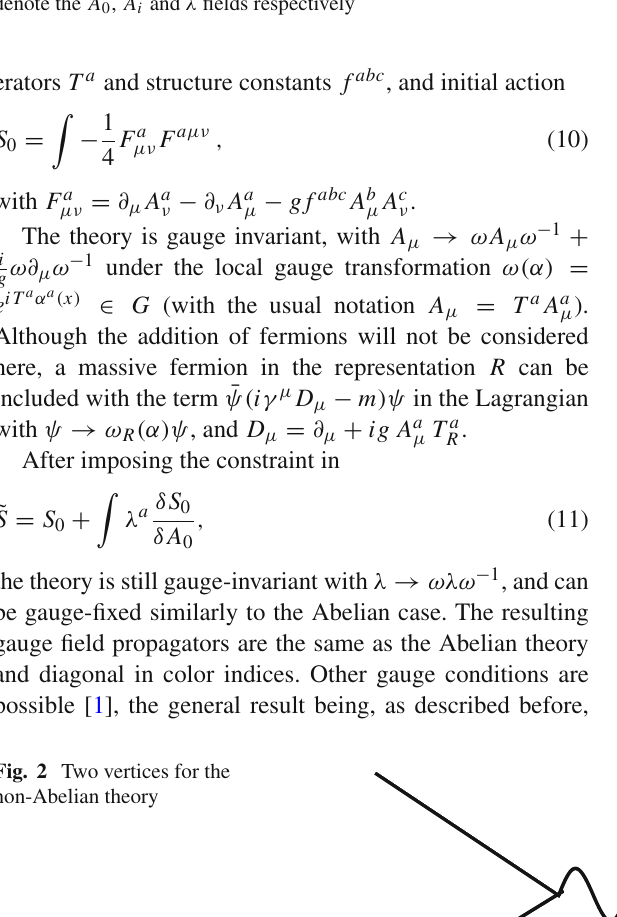
Fig. 1 ThepropagatorscombinetoreproducetheCoulombinteraction between two static sources (large blobs). Solid, wavy and curly lines denote the A 0 , A i and λ fields respectively